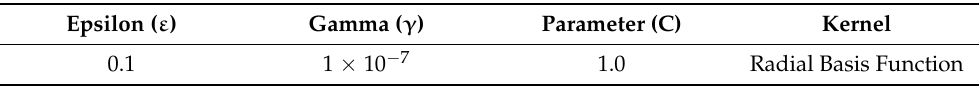
Table 6. Optimal values obtained from grid search for ε , γ , and C in the support vector regression (SVR)